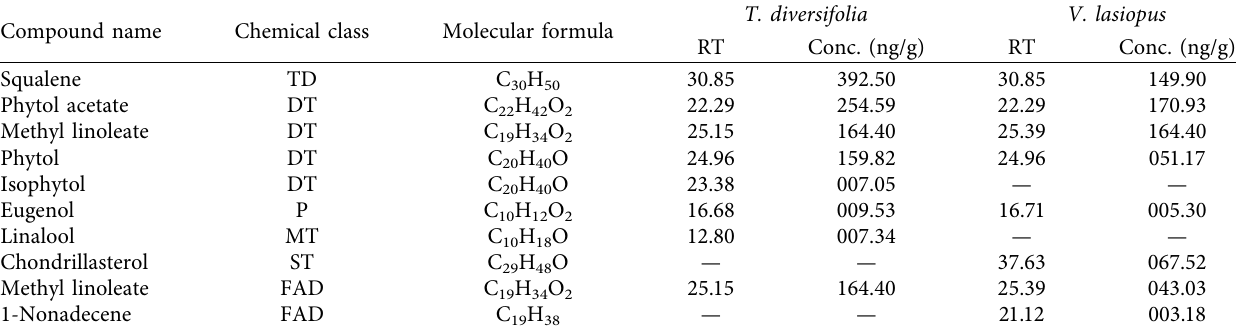
Table 2: Phytochemical analysis of insecticidal compounds in the DCM leaf extract of T. diversifolia and V. lasiopus